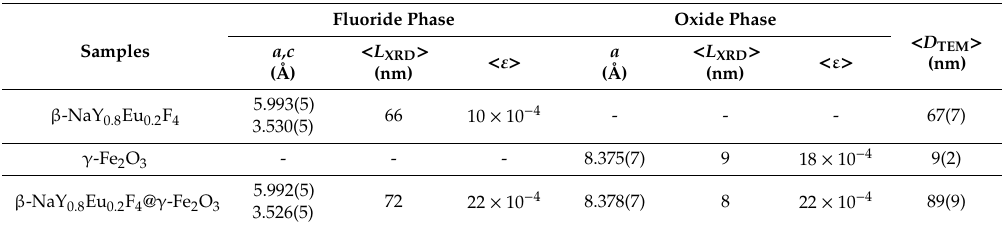
Table 1. Cell parameters, average crystal size and average micro-strain-induced lattice deformation, as inferred from Rietveld refinement. The average particle size inferred from transmission electron microscope (TEM) observation is given for